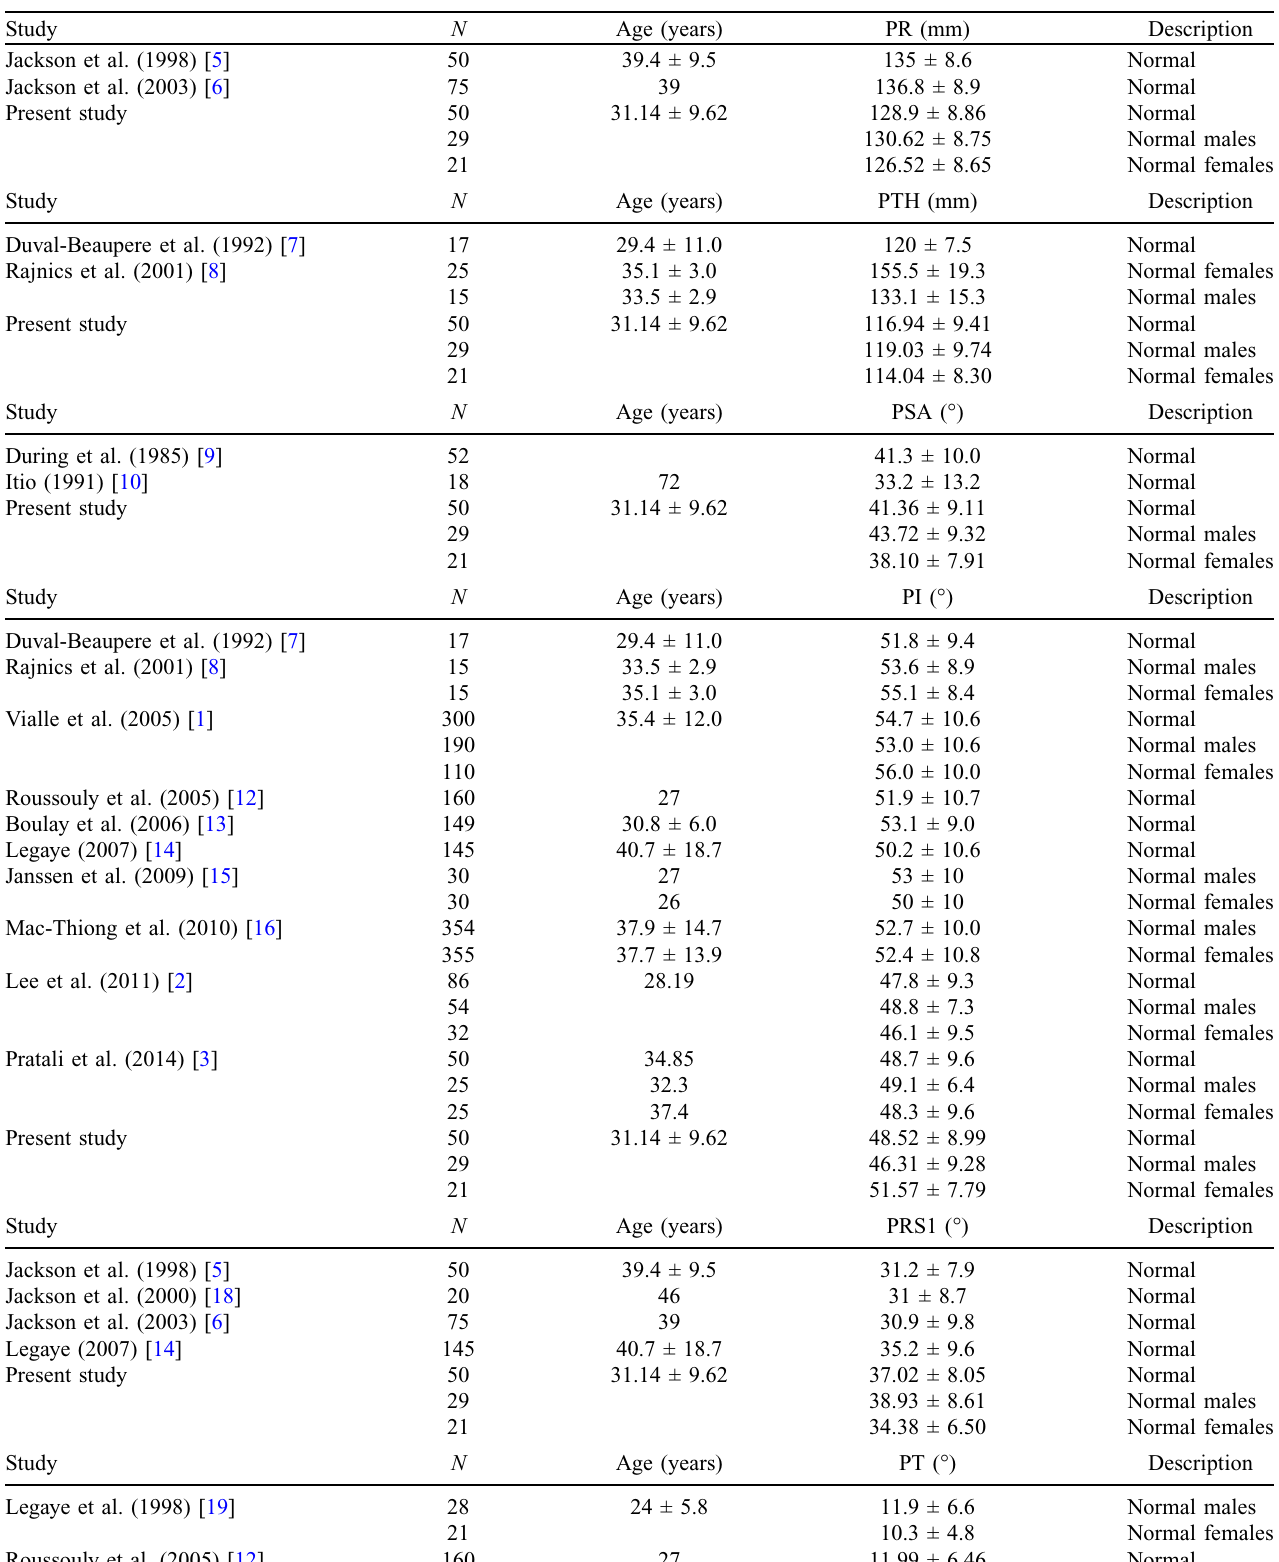
Table 6. Existing studies and reported